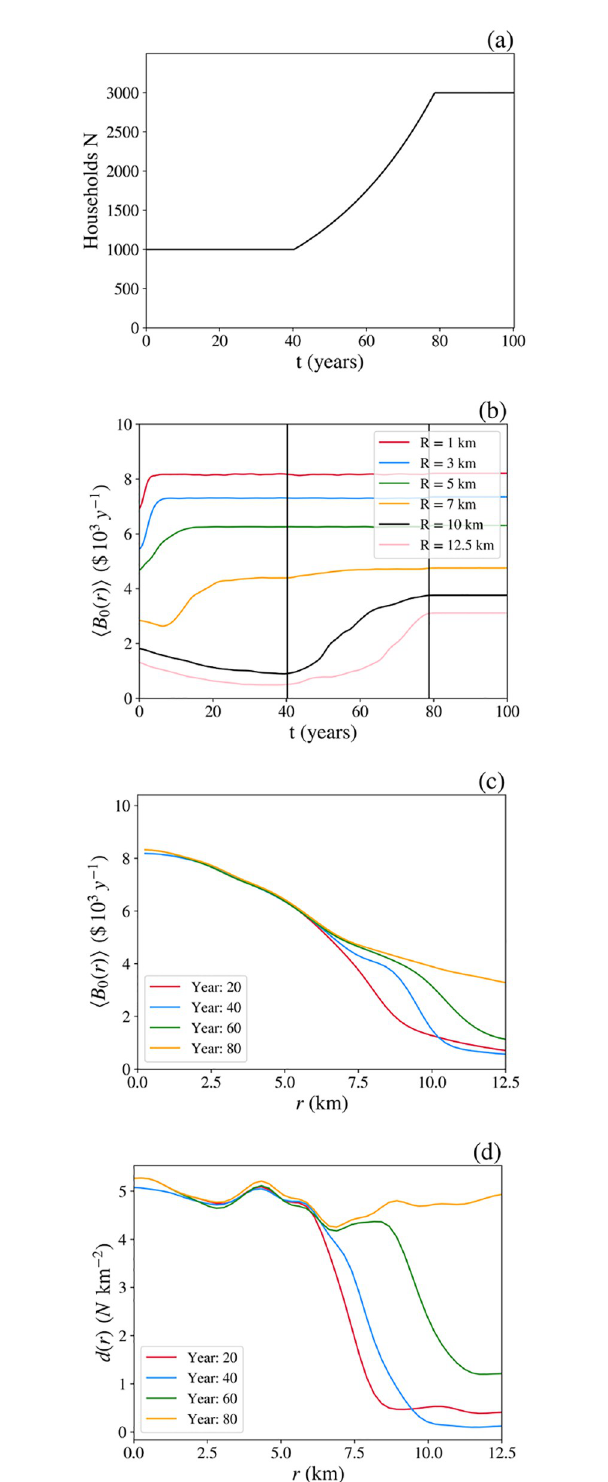
Fig 14. Supply-demand dynamics due to an increase in the number of households. ( a ) Number of households N ( t ) vs. t . ( b ) Mean price of occupied dwellings vs. t at various distances r (see legend) from the peak of U 0 , where gray lines represent initiation and cessation of household creation. ( c ) Mean price of occupied dwellings vs. r at various t (see legend). ( d ) Spatial density of households d ( r ) vs. r at various t (see legend).